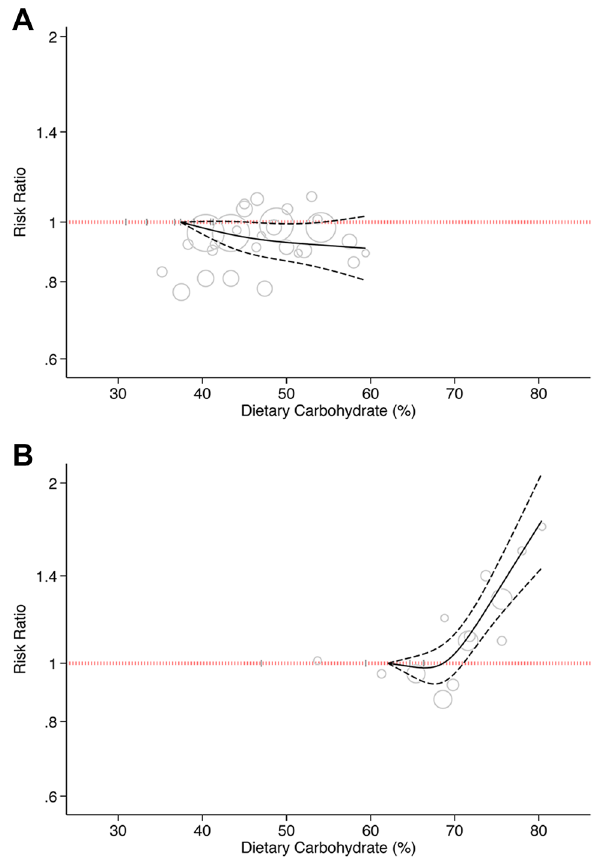
Figure 3. Dose–response association between carbohydrate intake and risk of type 2 diabetes. ( A ) Western countries. ( B ) Asian countries. Solid line represents non-linear dose response and dotted lines represent 95% confidence interval. Circles represent hazard ratio point estimates for carbohydrate intake categories from each study with circle size proportional to inverse of standard error. Small vertical grey lines are baseline carbohydrate intake categories in each